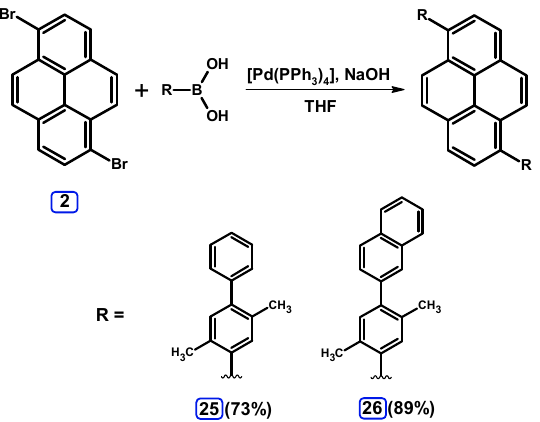
N Scheme 16. Obtaining compounds 29 and 30 in coupling reaction with (hetero)arylboronates [51]. In 2014 and 2015, Jonathan R. Nitschke and co-workers published two papers about the pyrene- edged cages where 1,6-bis(4-aminophenyl)pyrene 31 or 1,6-bis(3-aminophenyl)pyrene 32 were used